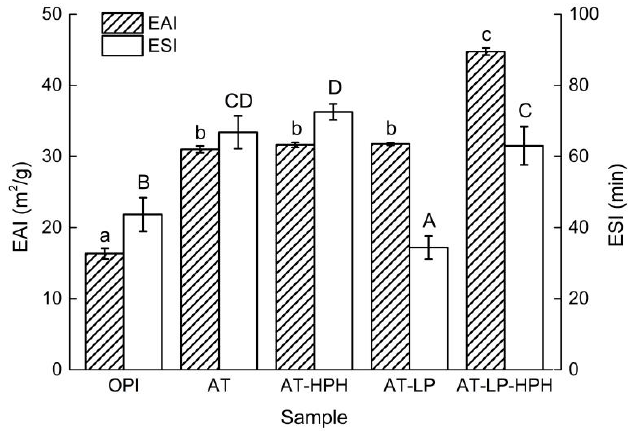
Figure 5. Emulsifying properties of OPI and the modified samples. Different lowercase and uppercase letters represent significant differences at p < 0.05.